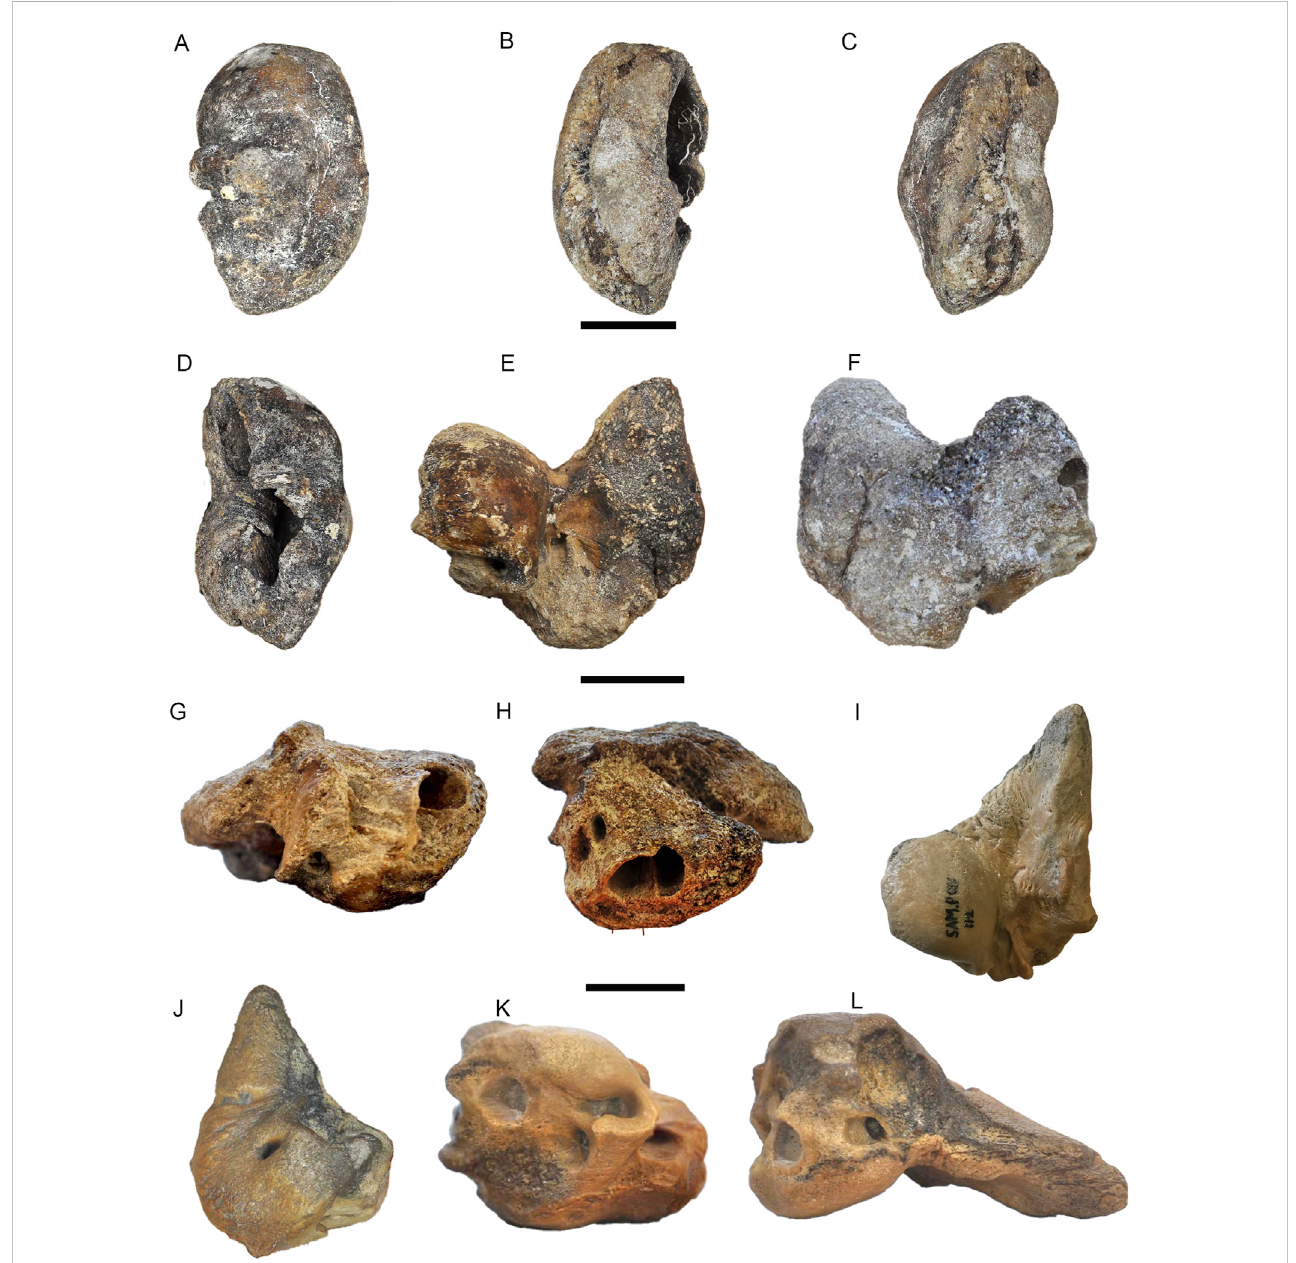
FIGURE 2 Balaenoptera cf. musculus SAM-PQ-3082 in (A) ventral, (B) dorsal, (C) medial, and (D) lateral view, scale=5 cm. Balaenoptera sp. SAM-PQ-3086 in (E) posteromedial, (F) posterolateral, (G) posteroventral, and (H) dorsal view, scale=2 cm. Diunatans luctoretemergo SAM-PQSS-223 in (I) medial, (J) lateral, (K) posterior, and (L) dorsal view, scale=2